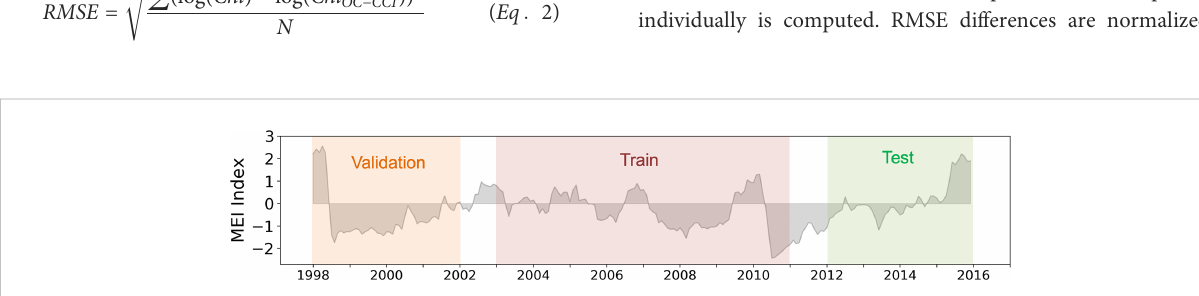
FIGURE 2 Time-series of the MEI. The validation, training and test time periods used to compare the implemented regression models ’ performances are indicated as orange, red and green fi lled sections,